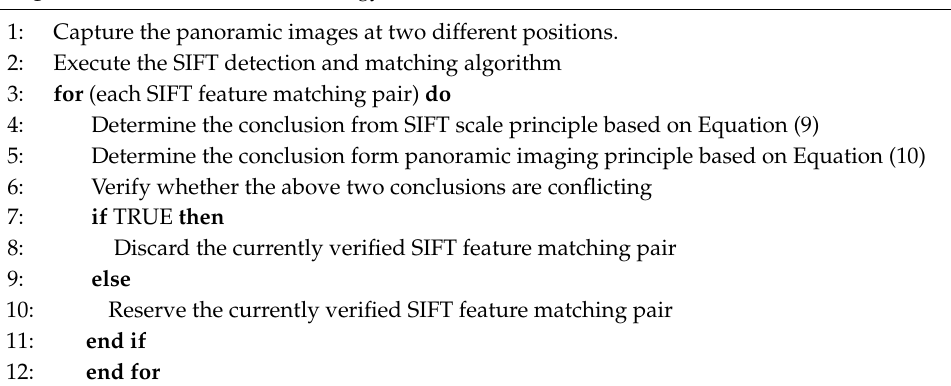
Algorithm 1. Pseudo code of Strategy